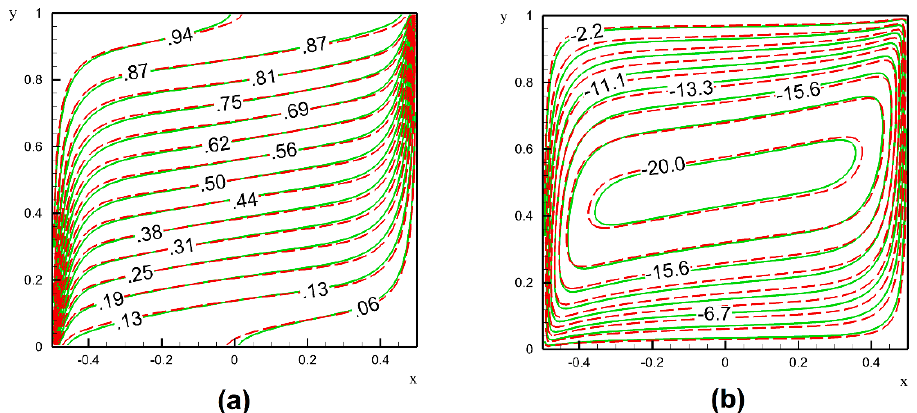
Figure 7. Effect of nanoparticles on heat transfer in porous media ( a ) case 1, ( b ) case 2 [81]. The subfigure a and b represent the behavior of nanoparticles in porous media in two different cases